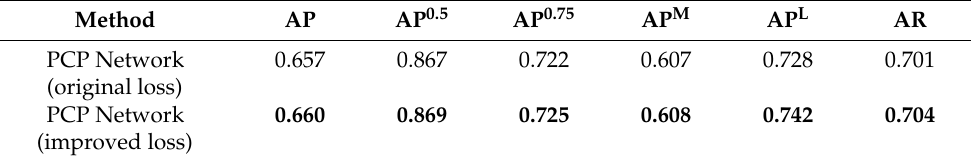
Table 3. Ablation study results: original l 1 loss vs. improved l 1 loss on the COCO2017 val dataset. Superscripts M, L of AP stand for medium and large objects. The highest values are indicated in